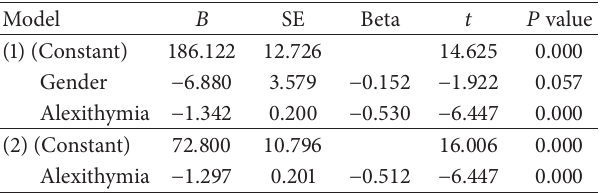
Table 3: The results of multiple analysis of regression (backward) between gender and alexithymia with self-efficacy in academic